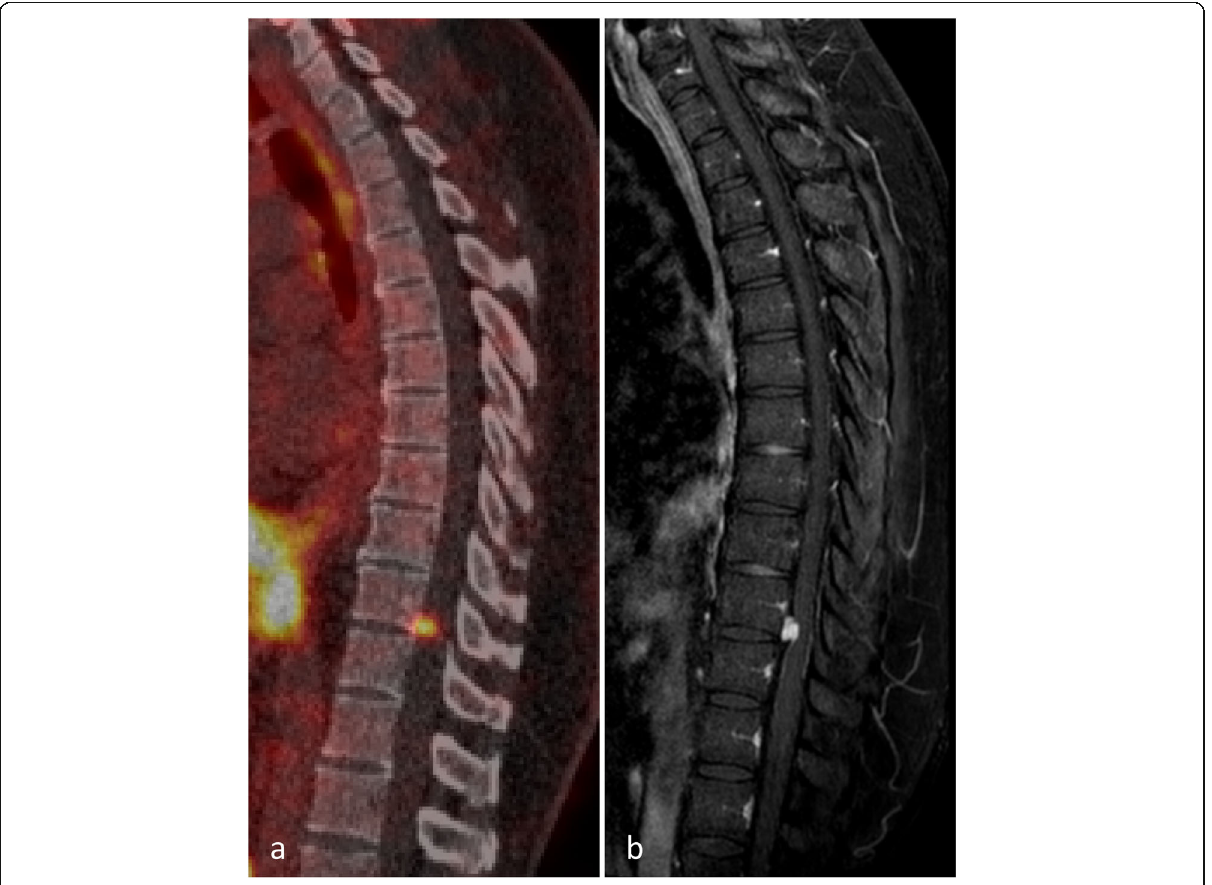
Fig. 1 Images of patient 1. a Uptake dorsal of the tenth thoracic vertebra suspicious for leptomeningeal/drop metastasis on 68 Ga-PSMA PET/CT.